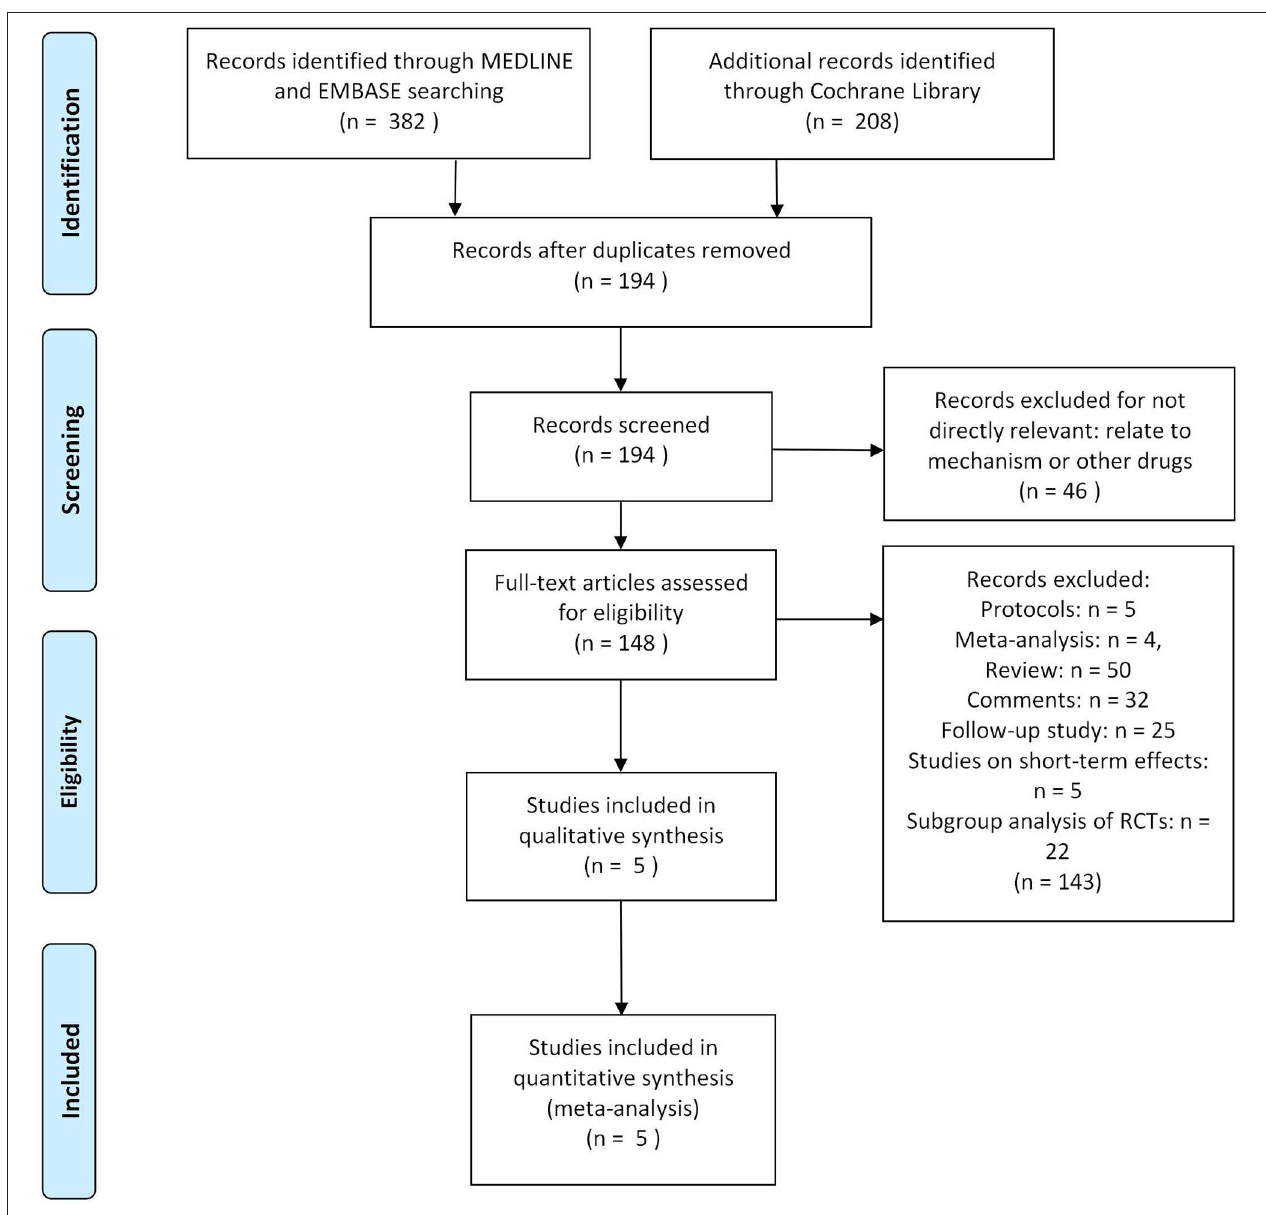
FIGURE 1 | The study search, selection and inclusion process.